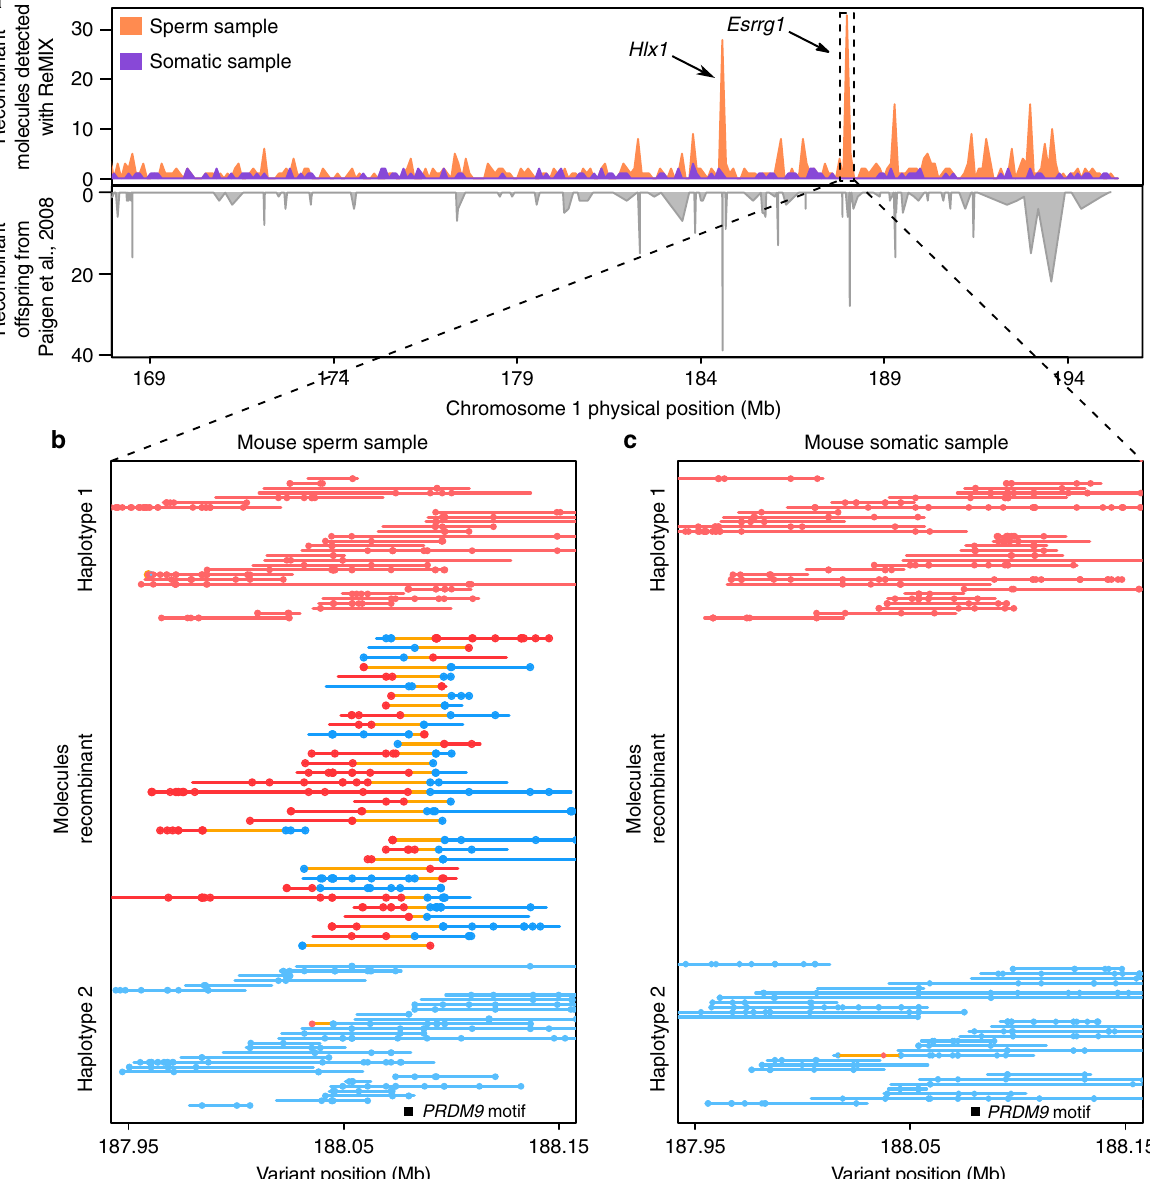
Fig. 2 ReMIX correctly detects fi ne-scale recombination variation and hotspots on mouse chromosome 1. a The recombination rate on the south end of chromosome 1 (169 – 195.4 Mb, mm10), determined by ReMIX (orange above axis) corresponds well to the rate described in Paigen et al. 8 (gray below axis). As a negative control, somatic tissue (purple) shows a minimal number of dispersed recombinant molecules. b The three types of molecules identi fi ed by ReMIX in the sperm sample in the region of a well-known recombination hotspot ( Esrrg1 , 8,28 ). Each line represents a single molecule and each dot a high-quality heterozygous variant phased as haplotype 1 (red) or haplotype 2 (blue). Joining lines represent the inferred phase of the molecule with orange lines indicating a switch between haplotype states. For graphical reasons, we represented all the recombinant molecules detected by ReMIX but only 30 random (classical) molecules for each haplotype. c The corresponding region for somatic tissue lacks recombinant molecules. PRDM9 plays a role in initiating crossovers at the Esrrg1 hotspot and has a DNA-binding motif (black bar) located near the midpoint of the detected recombinant